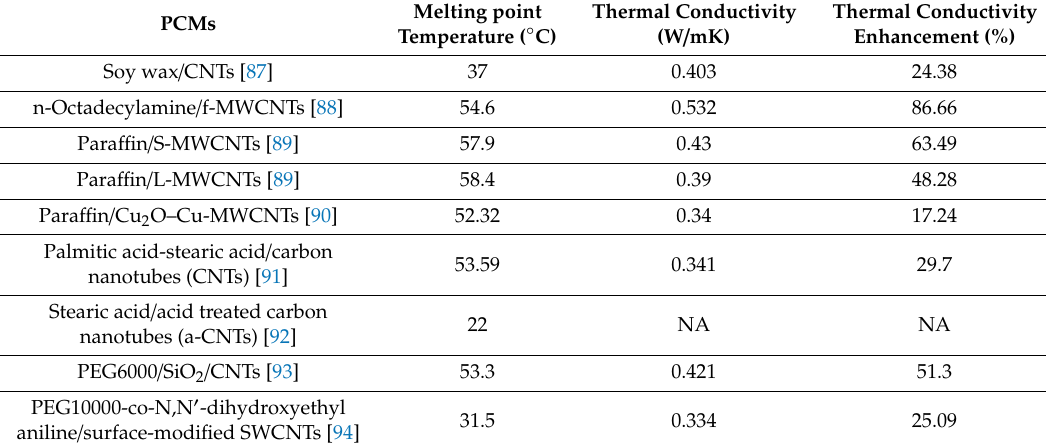
Table 3. Thermal properties of organic PCMs filled with carbon